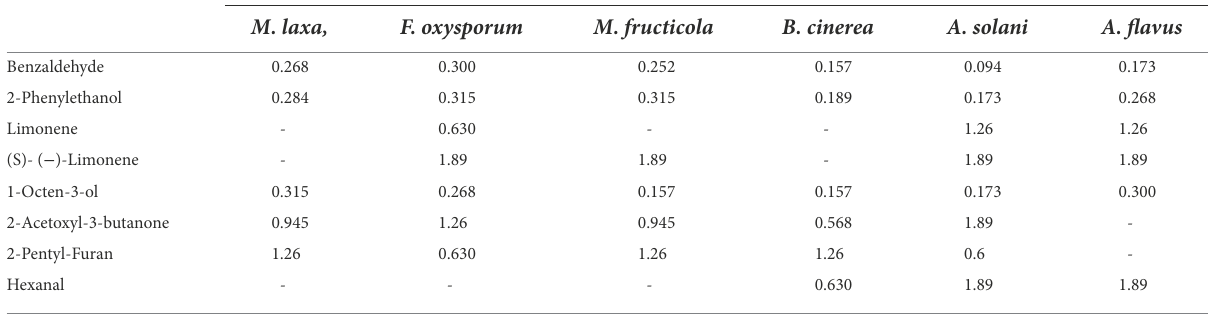
TABLE 5 In vitro MICs of several pure VOCs produced by C. fimbriata against tested fungal pathogens.